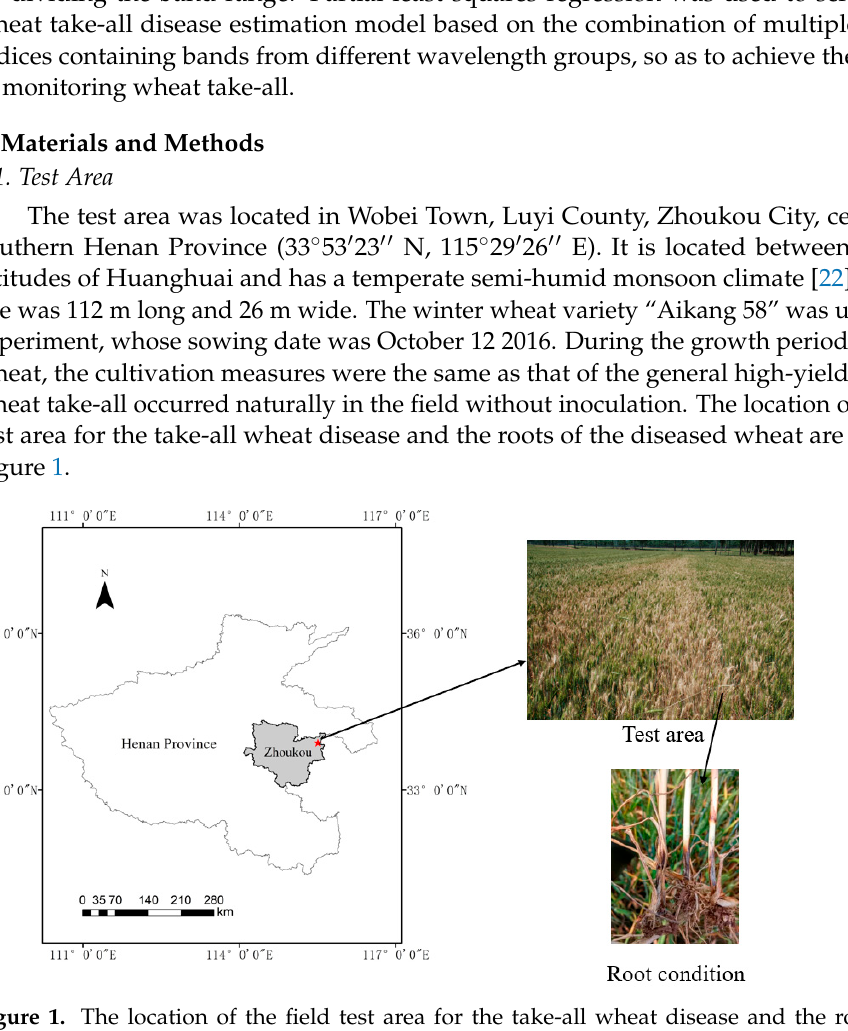
Figure 1. The location of the field test area for the take-all wheat disease and the roots of the diseased diseased wheat.